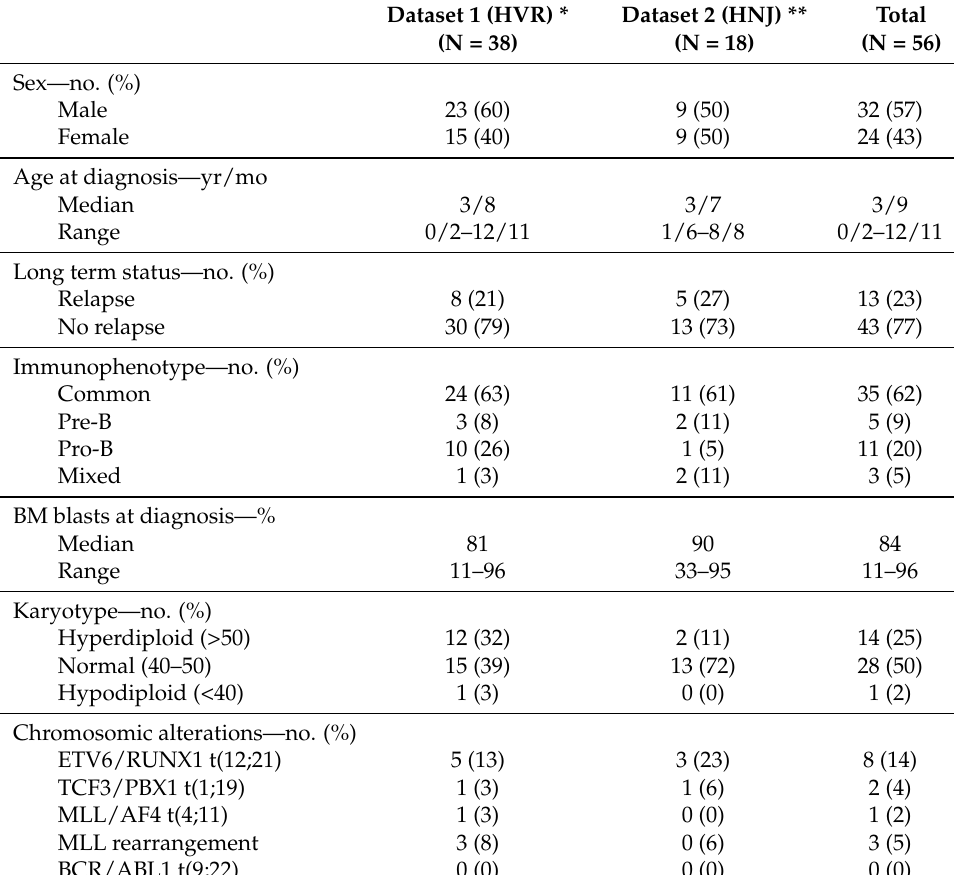
Table 1. Patient